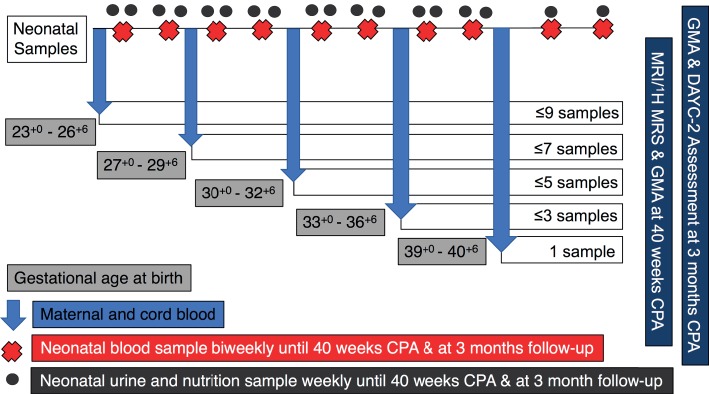
Schematic representation of UNICORN sampling regime. Samples of neonatal blood, urine, and nutrition will be collected weekly or bi-weekly for the duration of the infants stay in hospital. Magnetic resonance imaging (MRI) and magnetic resonance spectroscopy (1H-MRS) will be performed at term corrected postnatal age (CPA). Infants will also undergo a general movements assessment (GMA) at CPA and at 3 months CPA. At the follow-up appointment at 3 months CPA, further neurological assessment will be completed using the Developmental Assessment of Young Children – Second Edition (DAYC-2) assessment tool.